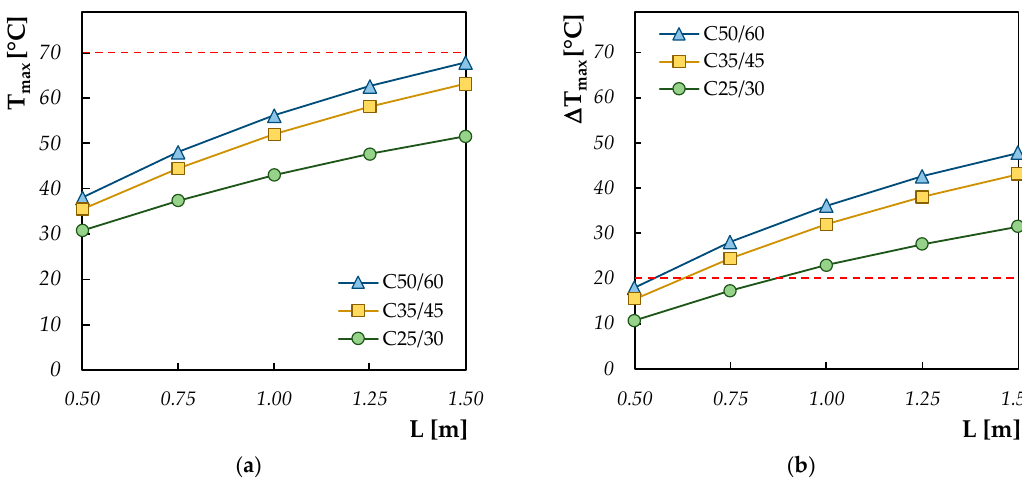
Figure 7. Maximum temperature ( a ) and maximum thermal gradient ( b ) by varying the concrete element’s thickness.